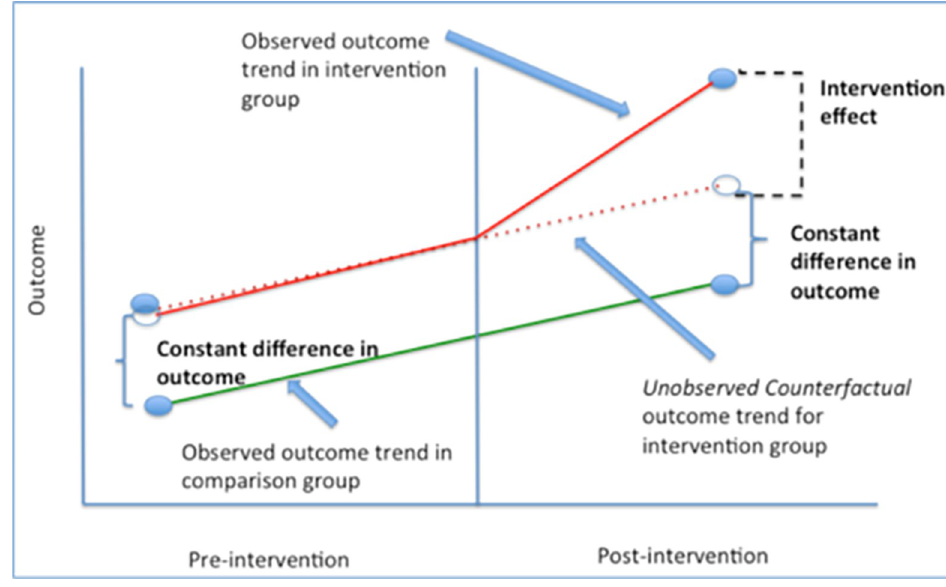
Fig 3. DID graphical explanation. Source : See